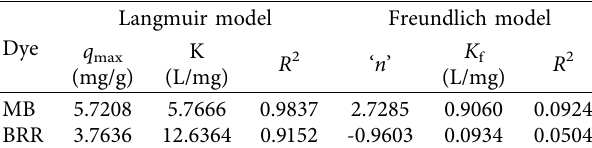
Table 3: The Langmuir and freundlich parameters of adsorption isotherm at 25 °